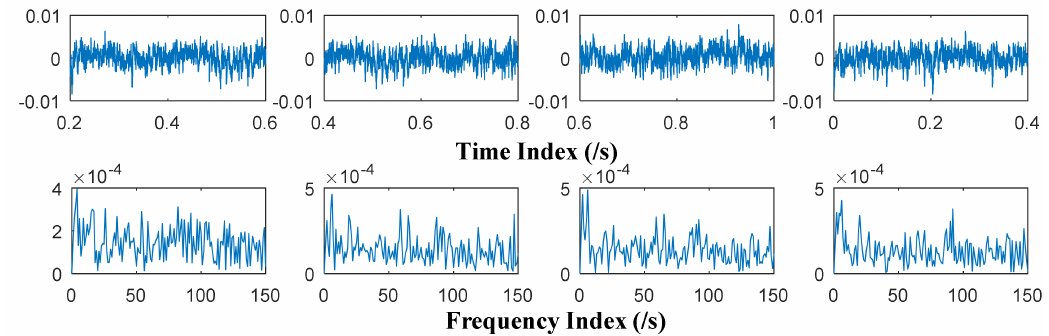
Figure 16. Time and frequency domain plots of collected multivariate